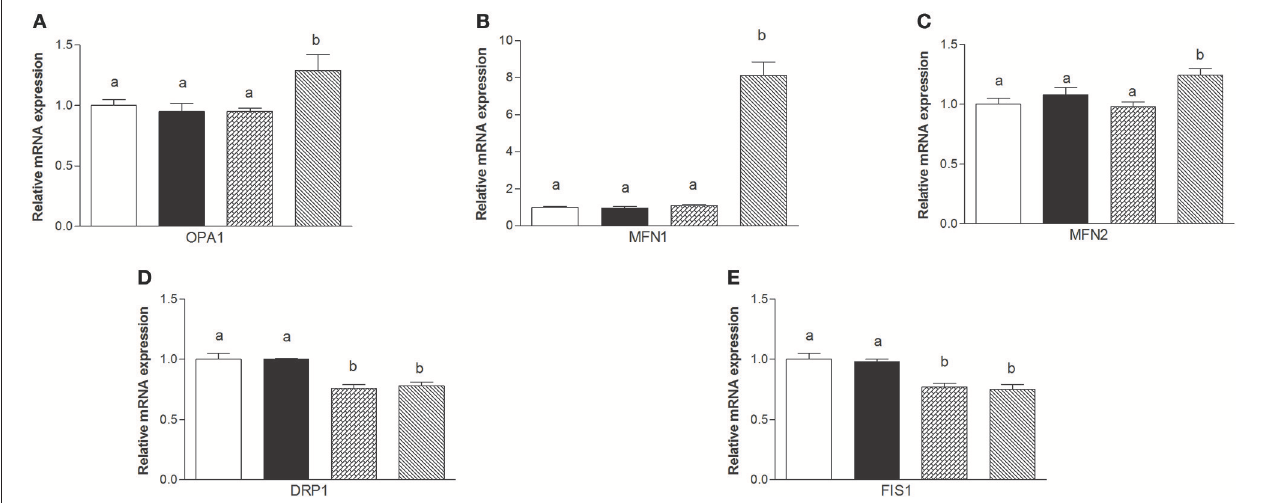
FIGURE 6 | Effects of oral administration of human, donkey, and cow milk on skeletal muscle mitochondrial dynamics. The graphs summarizing the results of real time PCR represent the relative levels of mRNAs for OPA1 (A) , MFN1 (B) , MNF2 (C) , DRP1 (D) , and FIS 1 (E) . Data are presented as means ± SEM from n = 7 animals/group. Labeled means without a common letter differ ( P <